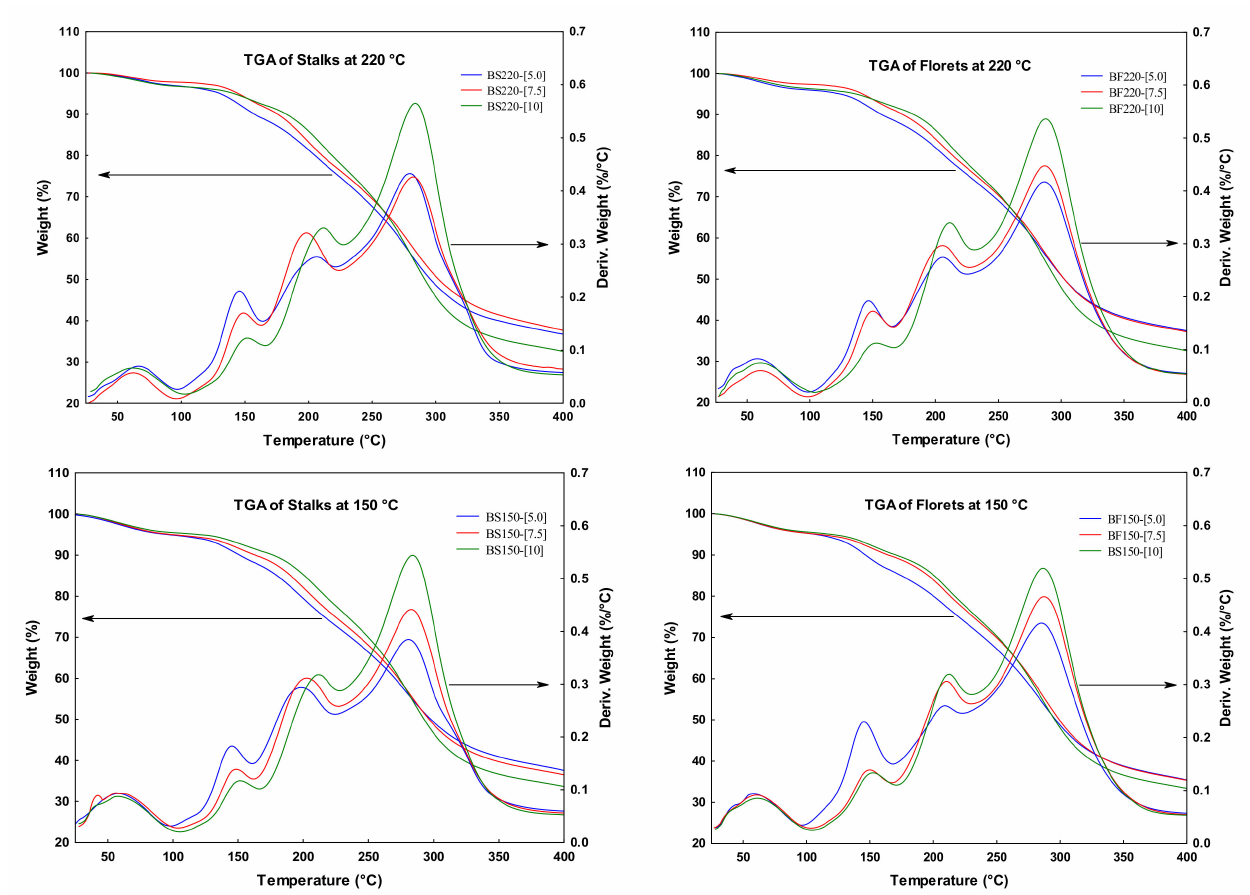
Figure 4. Thermogravimetric analysis of the BJ-MX powders. TGA is read on the left side of each plot, while the derivative of the weight may be read on the right